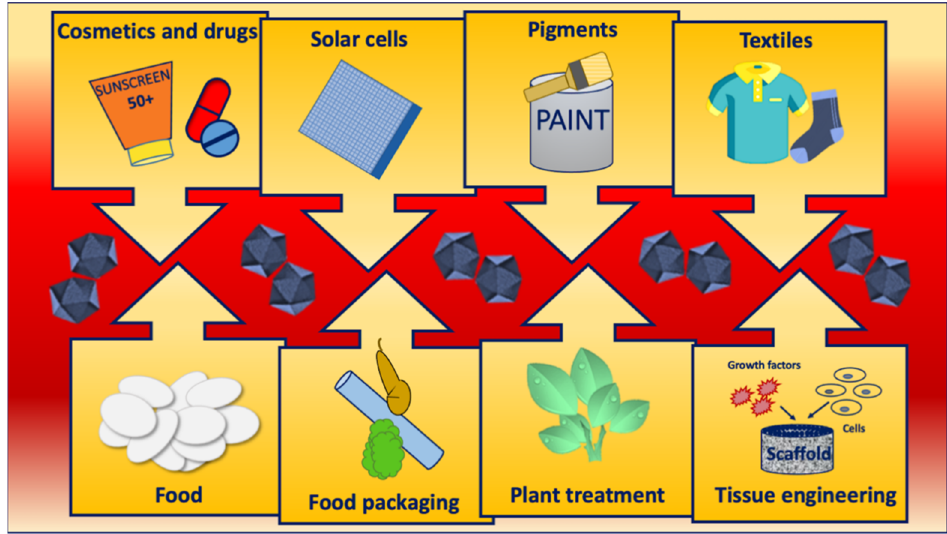
Figure 2. Main applications of TiO 2 NPs.